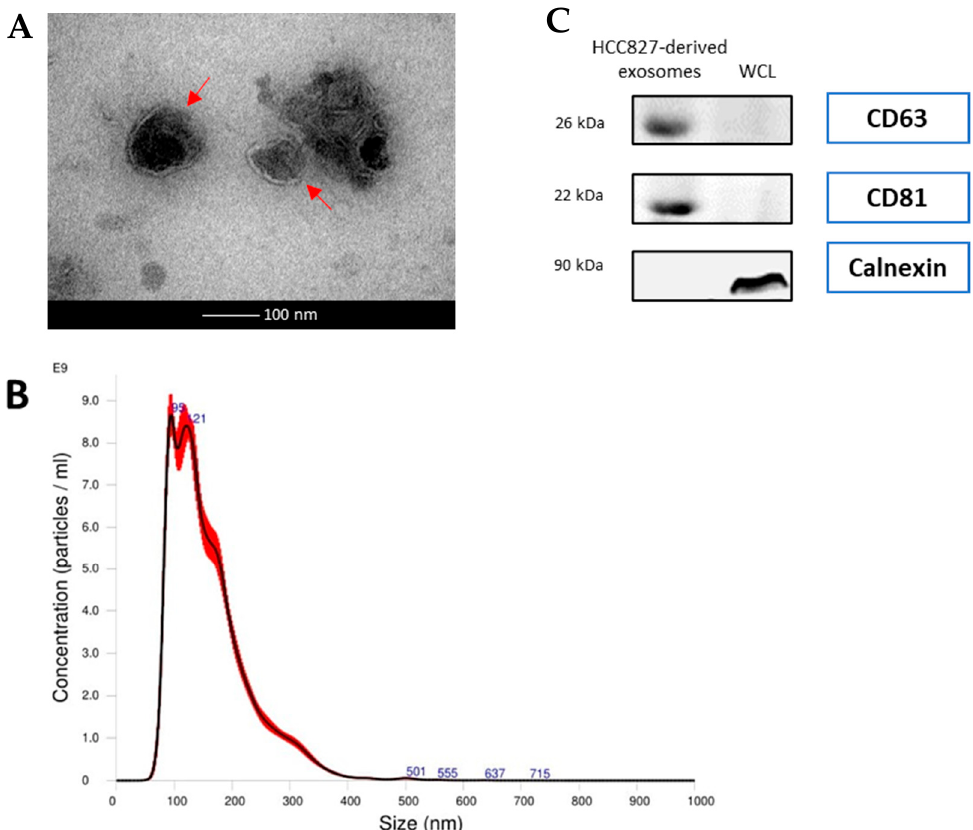
Figure 2. Characterization of exosomes from the HCC827 cell line ( A ) Transmission electron micro- scope (TEM) images of exosomes isolated from HCC827 cells. The bar represents 100 nm. Red arrows indicate exosomes. ( B ) The size distribution of serum exosomes determined by nanoparticle tracking analysis (NTA). ( C ) Western blot analysis of exosome markers (CD63 and CD81) and negative markers (calnexin) in equivalent amounts of protein from HCC827-derived exosomes and A549 whole cell lysates (WCL) (as a control). (Original whole Western-blot Images and densitometry reading in Figure 2 and Table S3).